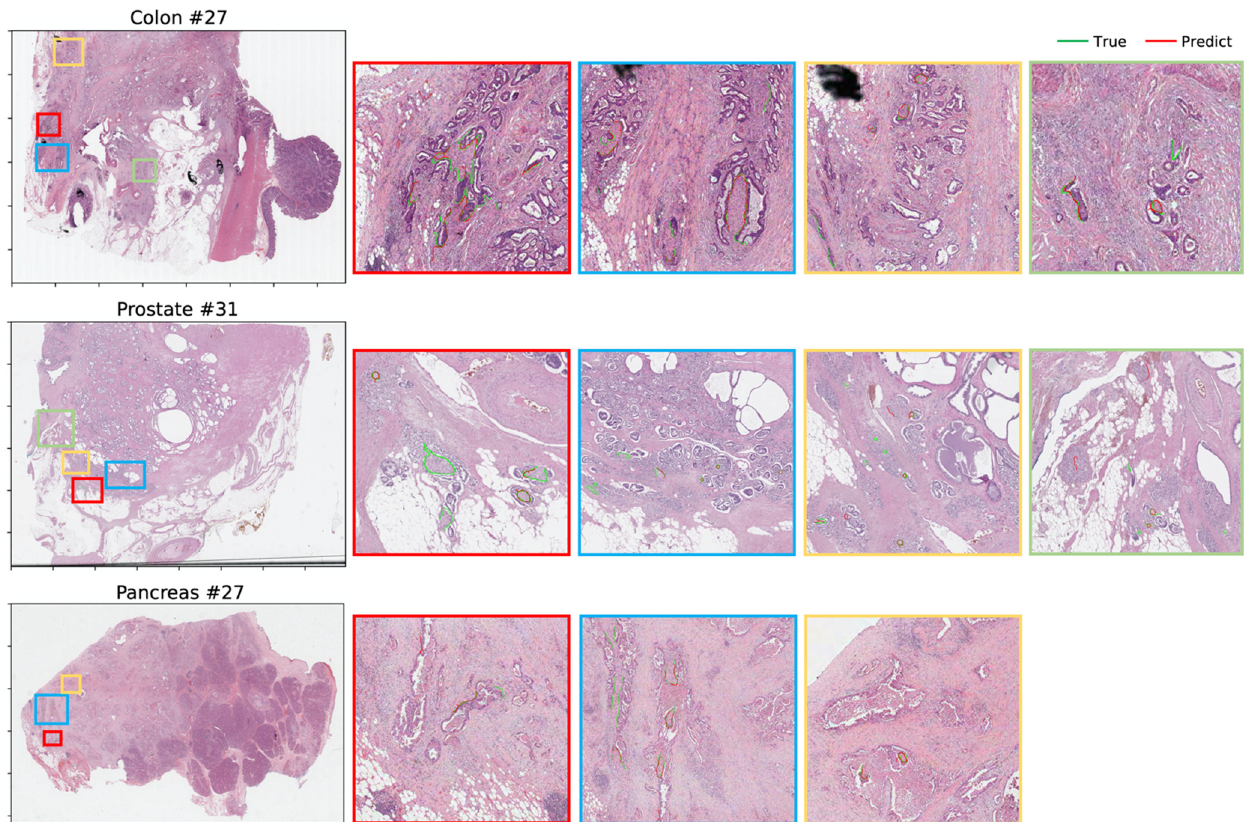
Figure 8. Examples of predicted PNI for three different cancers.